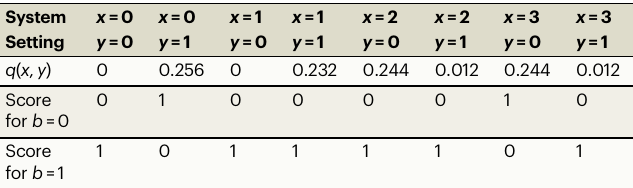
The fi rstrowrepresentstheprobabilityofchoosingaspeci fi csettingforAlice ’ sinput x andBob ’ s input y . Thesecond and third rowshowthe score assignmentforeach input-output con fi